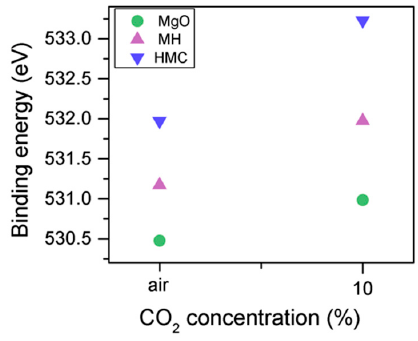
Figure 9. O1s BE for samples exposed to air and CO 2 for seven days.